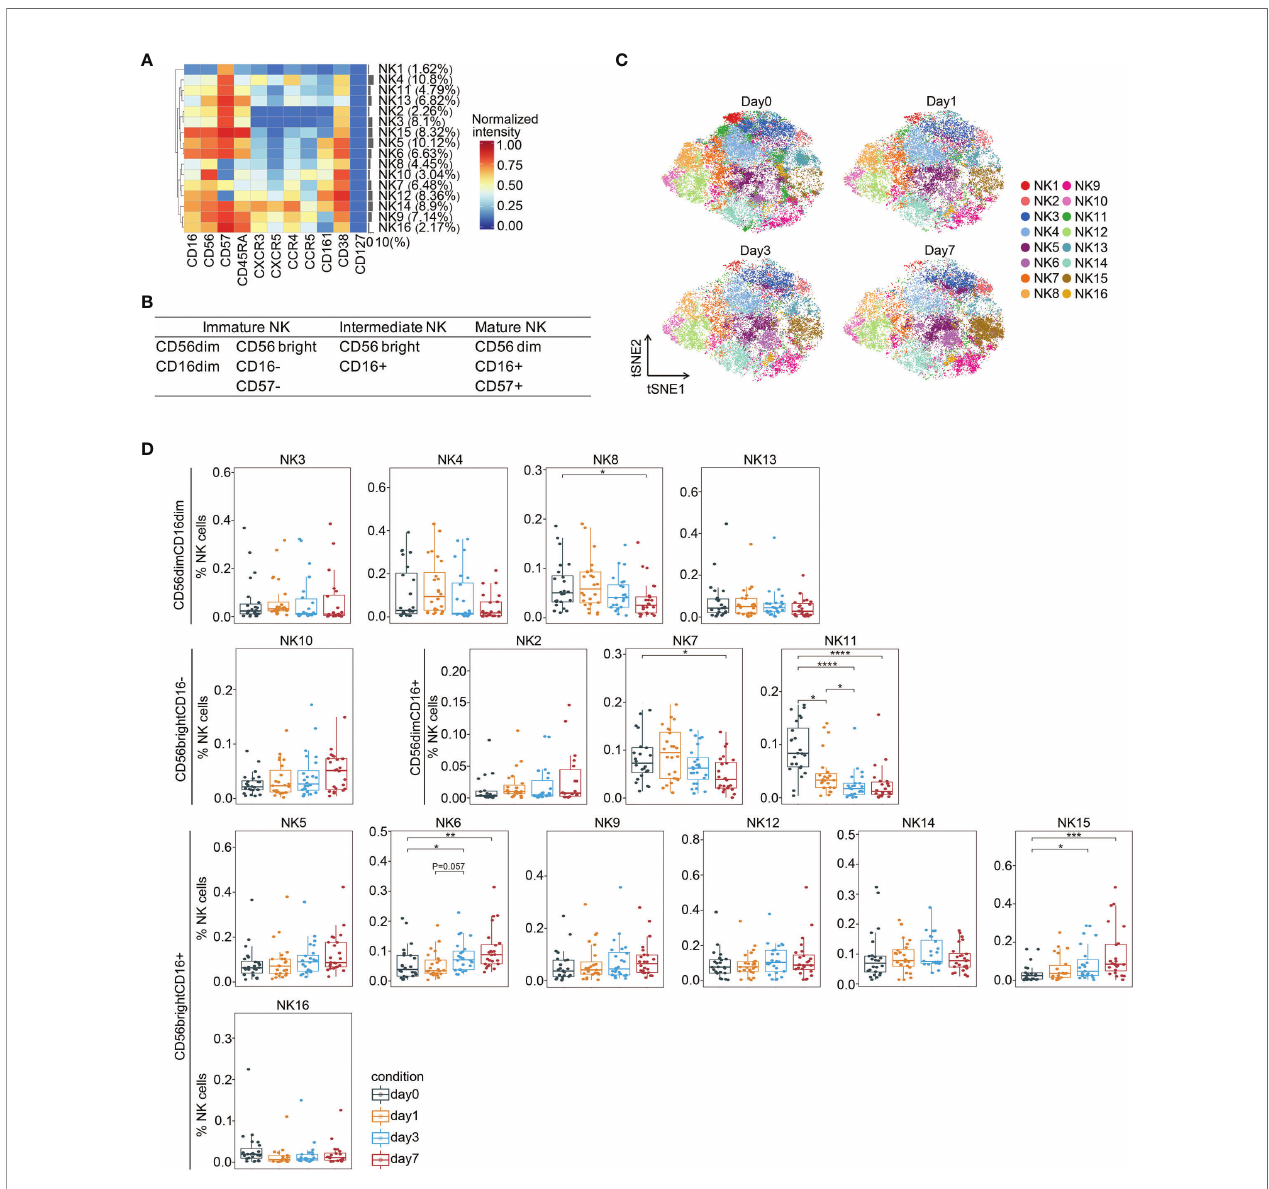
FIGURE 5 | In-depth analysis of NK cell subsets during the perioperative period. (A) Heatmap showing normalized expression of the markers for the 16 NK cell clusters. Clusters are grouped by marker expression patterns. The cluster numbers and relative frequencies are displayed on the right. (B) Surface marker combinations used to identify NK cell subsets. (C) FIt-SNE plots highlighting the distribution of NK cells at different time points. (D) Boxplots showing the frequencies of NK cell clusters during the perioperative period. *p < 0.05, **p < 0.01, ***p < 0.001, ****p < 0.0001 by Krustal-Wallis analysis with post-hoc Dunn test. P-value adjusted with the Benjamini-Hochberg